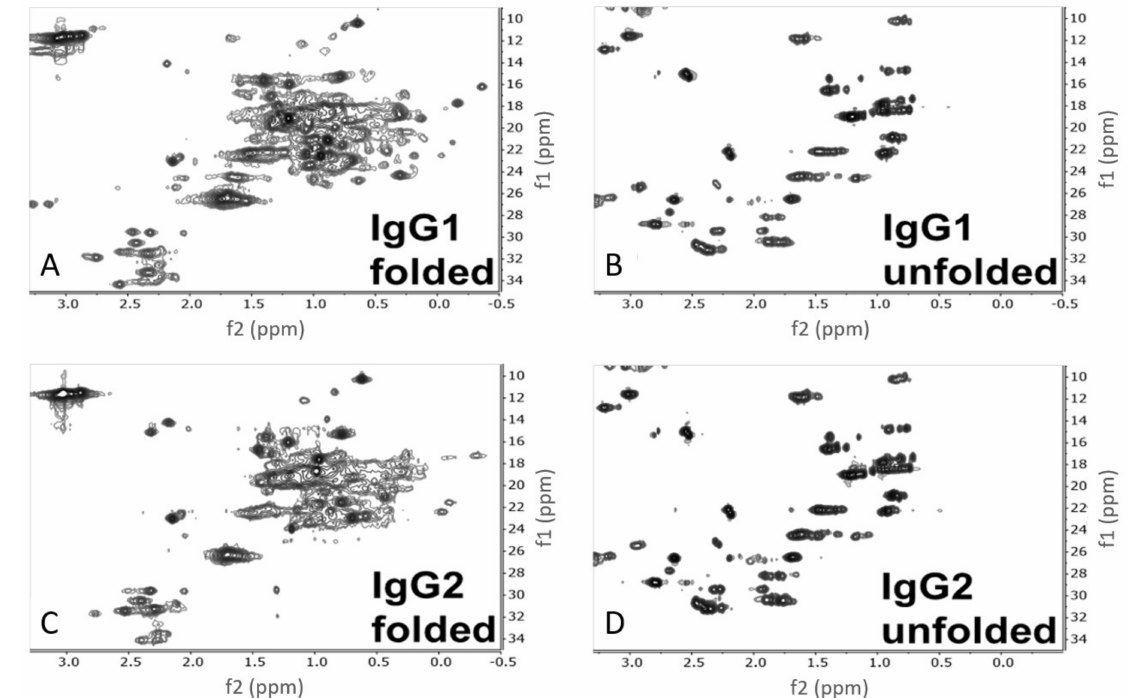
Figure 3. 2D 1 H- 13 C HSQC spectra of the folded and unfolded samples of IgG1 and IgG2. ( A , B ) show IgG1 in the folded and unfolded state respectively, whereas ( C , D ) show IgG2 in the folded and unfolded states respectively. 1 H is represented on the x axis (f2), and 13 C is represented on the y axis (f1).